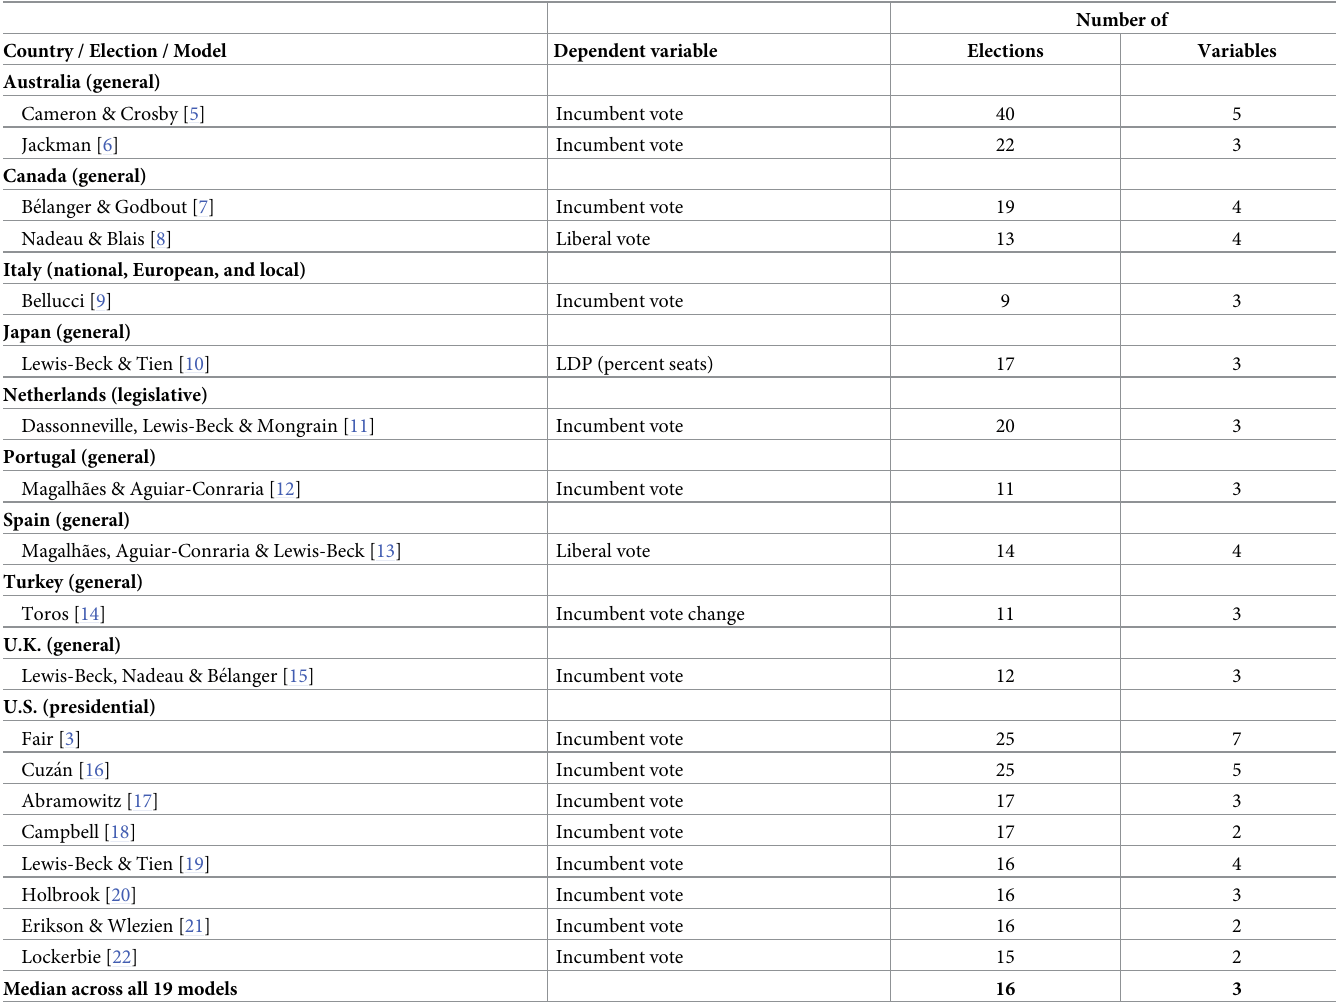
Table 1. Key features of the 19 models analyzed in this